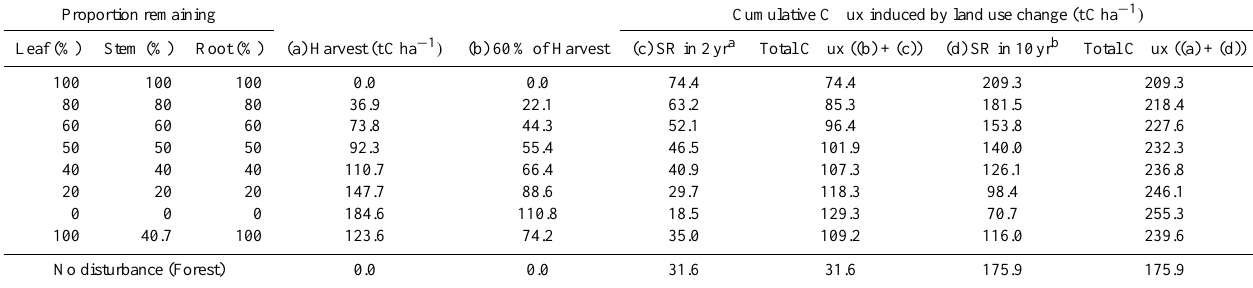
Table 5. Results of sensitivity analysis of the carbon flux for 2yr (1977–1978) and total carbon flux during 10yr (1977–1986) after de- forestation in the VISIT model. Deforestation occurred in 1976 in this simulation. Harvest rate changes and changes in the proportions of remaining leaves, stems and roots are shown.